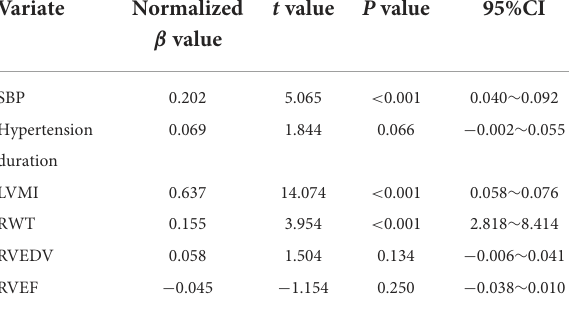
TABLE 5 Multivariate regression analysis results of right ventricular free wall longitudinal strain.